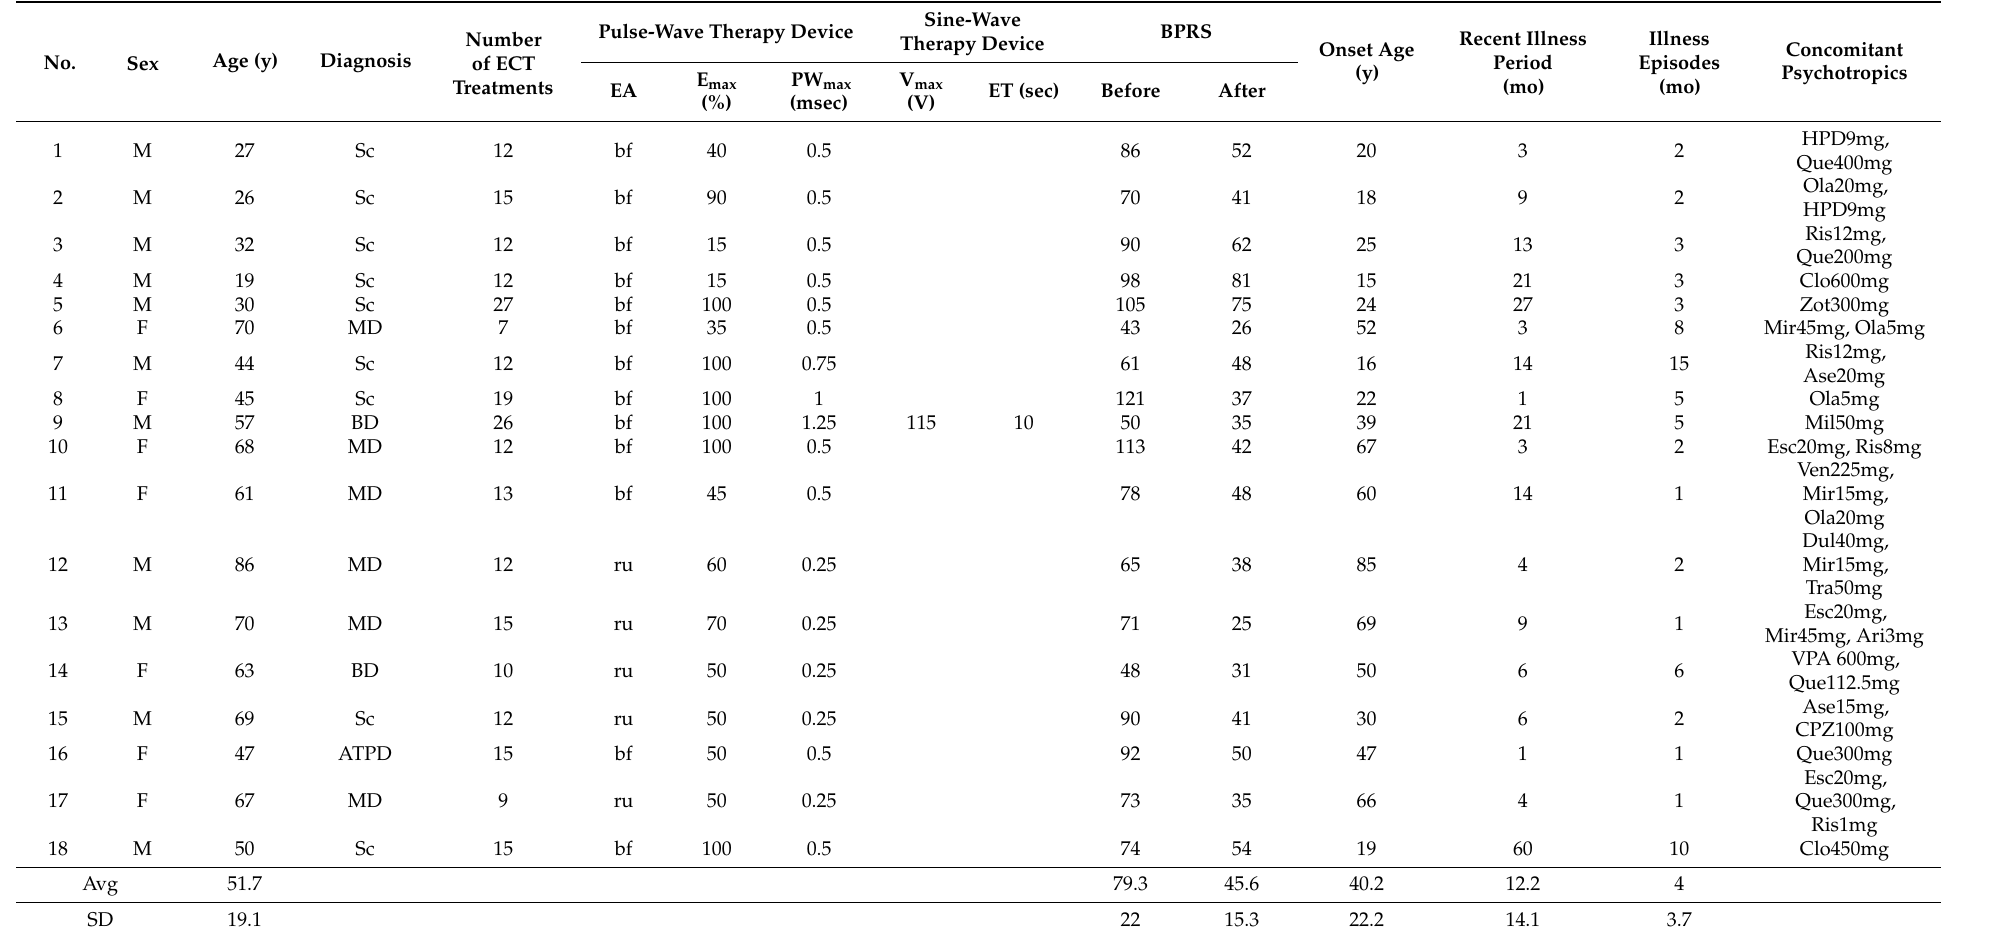
Table 1. Demographic